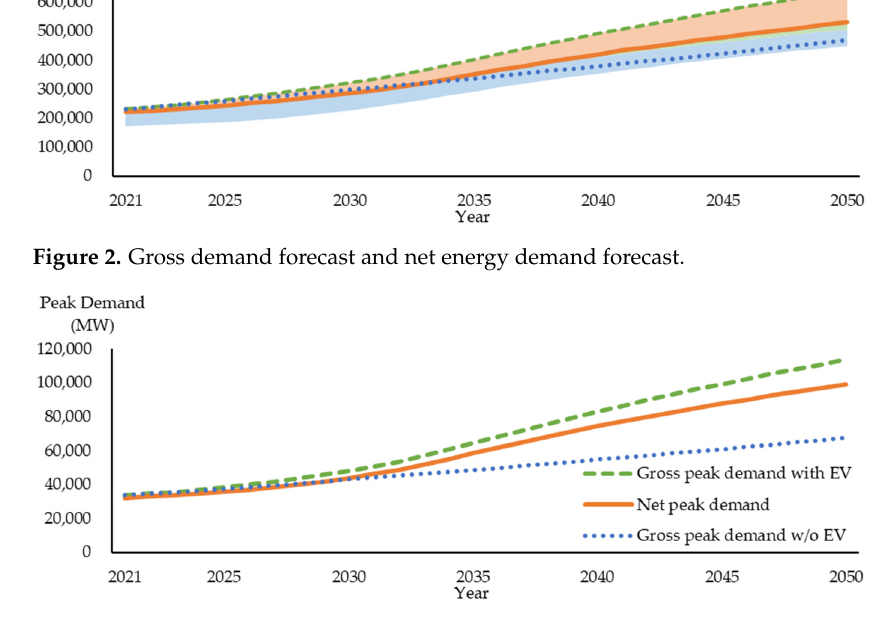
Figure 3. Gross peak demand forecast and net peak demand forecast.